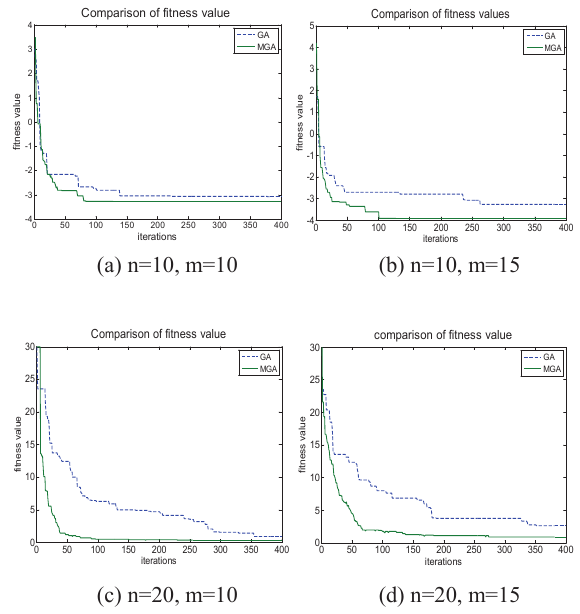
Fig.4. Fitness values comparisons of GA and MGA